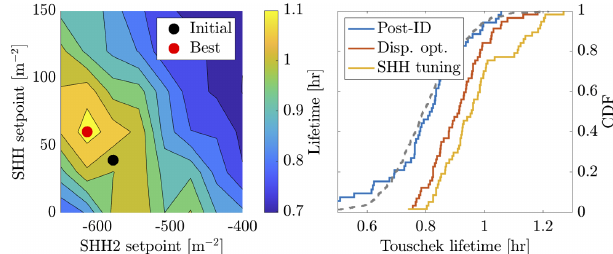
pole scans following the dispersion-weight optimization. The left plot shows the lifetime as a function of the SHH and SHH2 set points for one choice of error seed. In this example, the lifetime can be increased from 0.94 to 1.12 h. The right plot shows the distribution of Touschek lifetime after regular ID compensation in blue for the selected error seeds (gray curve shows the distribu- tion of all error seeds, see Sec. IV I), after optimizing the post-ID lifetime using LOCO dispersion weights (red curve, see Sec. VA) and after tuning the sextupole magnets (yellow